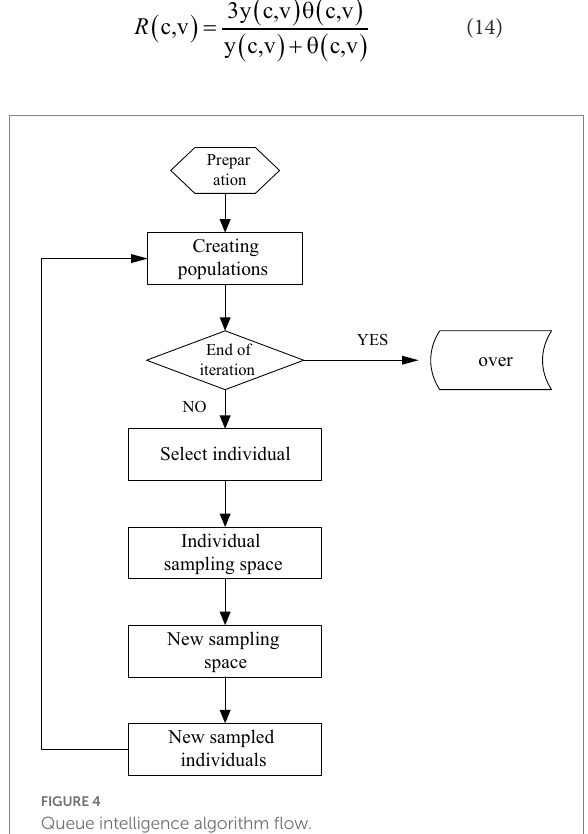
FIGURE 4 Queue intelligence algorithm